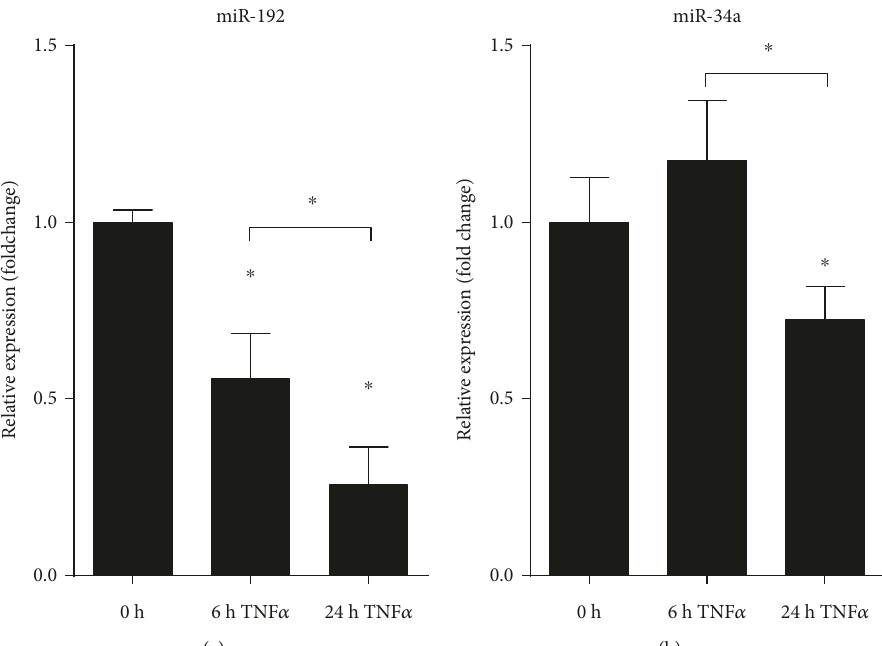
Figure 5: Decreased expression of miRNAs regulating Axl in TNF α triggered HT-29 colonic epithelial cells. The relative gene expression of miR-199a (a) and miR-34a (b) is shown from TNF α triggered HT-29 cells. Data are presented as the mean ± SEM; n = 3 ; ∗ p < 0 05